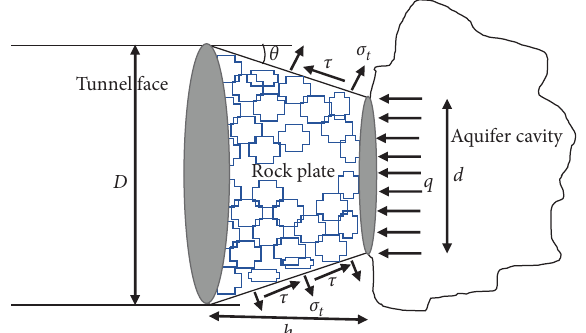
Figure 16: Three-dimensional damage model for the slippage of the antiburst wall.